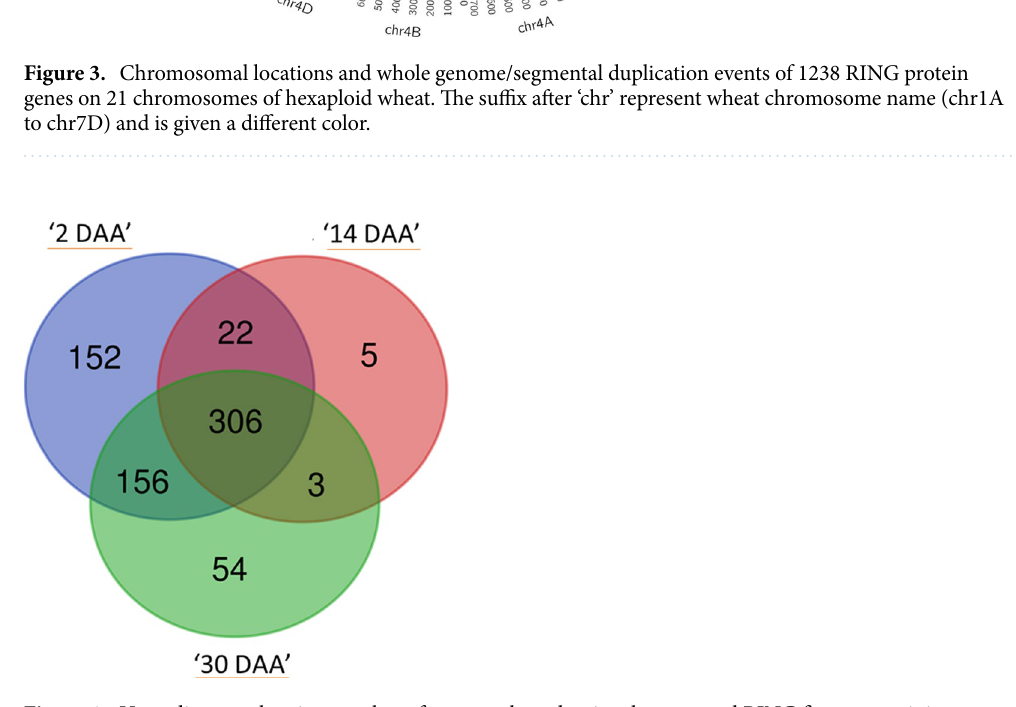
Figure 4. Venn diagram showing number of commonly and uniquely expressed RING finger containing genes at three seed developmental stages (2, 14 and 30 DAA). The data were taken from the publicly available RNA- seq databases of wheat (https:// wheat. pw. usda. gov/ GG3/ node/ 237). DAA stands for day after